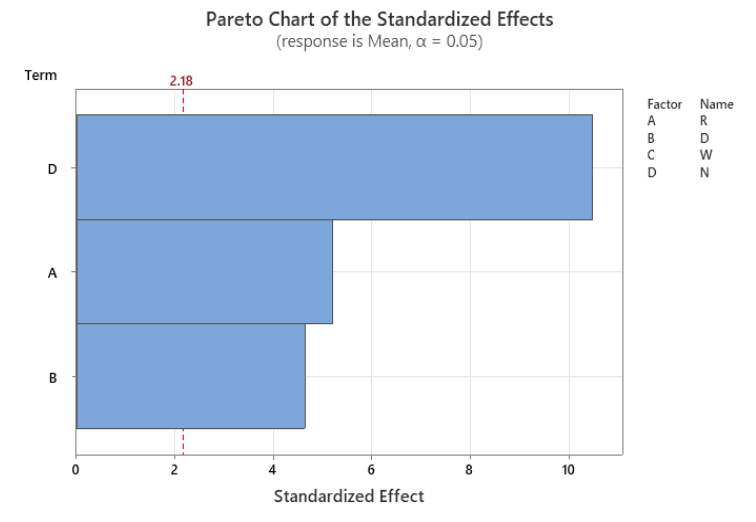
Fig. 4. Pareto chart for mean for D and N.